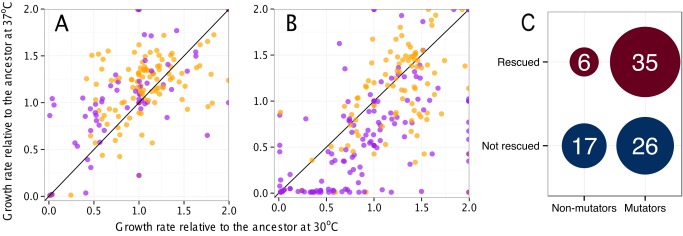
Temperature dependence of growth rate on alternative substrates.For all strain/substrate measurements, we determined the relative change in growth rate by changing temperature from 37°C to 30°C. For (A–B), purple dots are mutator strains; orange dots nonmutators. Points that fall outside of the plot range are plotted at the edge of the graph. (A) Effect of temperature change on 20k isolates. (B) Effect on 50k isolates. (C) For 50k isolates, the number of mutators and nonmutators that were rescued from no growth at 37°C to growth at 30°C.